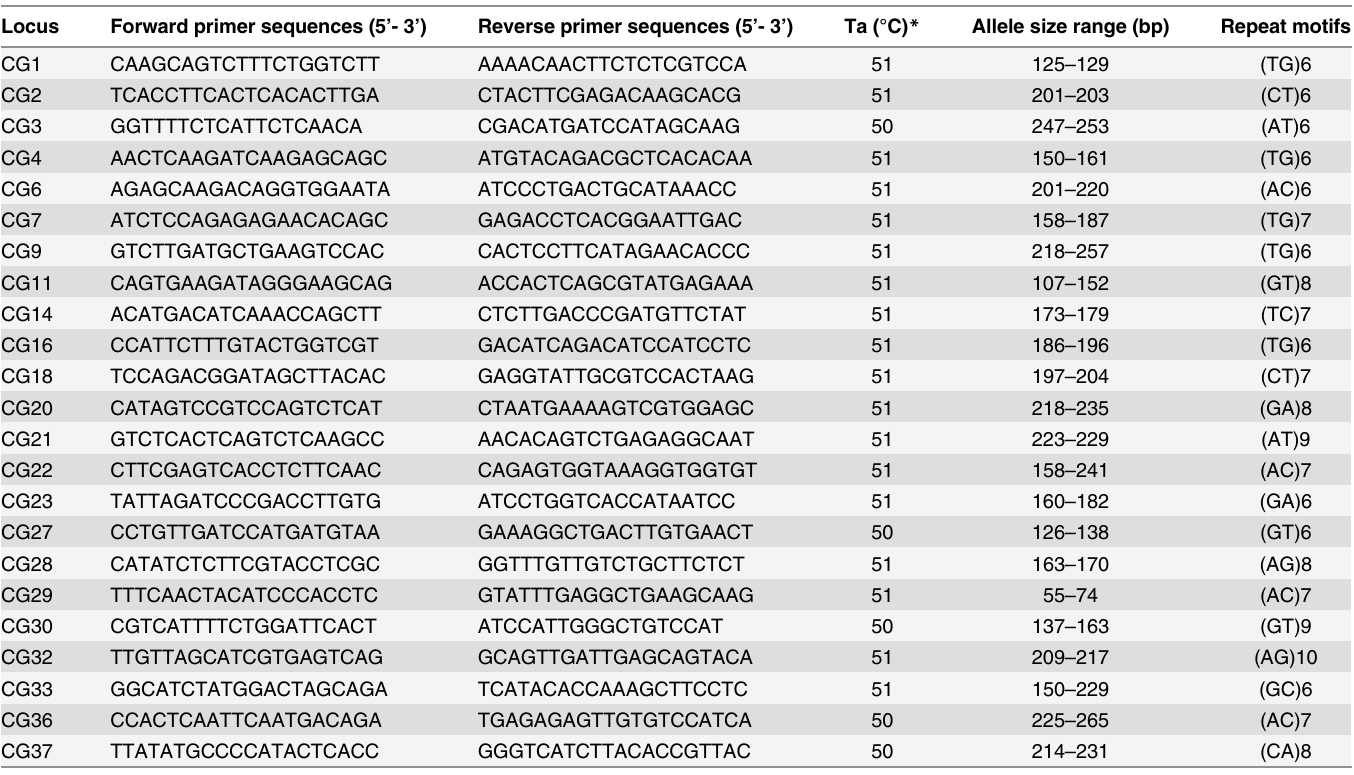
Table 2. Characteristics of 23 polymorphic microsatellite markers developed in this study for population genetic diversity analysis of Colletotri- chum gloeosporioides isolates.